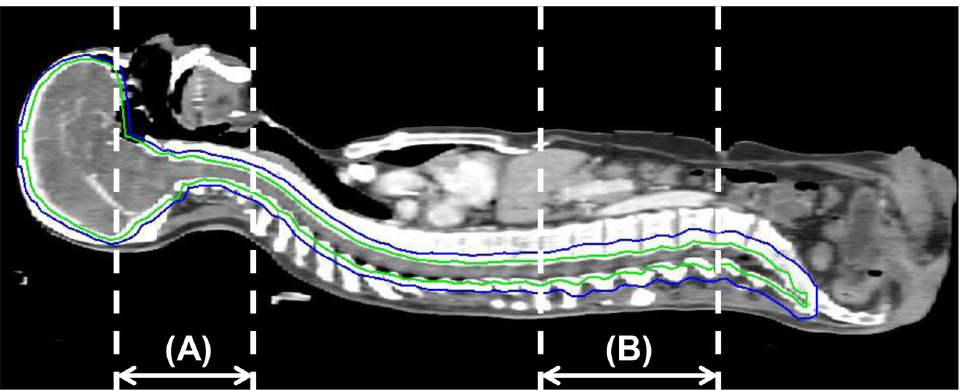
Figure 2. Target delineation for craniospinal irradiation (green line, clinical target volume [CTV]; blue line, planning target volume [PTV]) ( A ) Range of daily pre-treatment megavoltage computed tomography (MVCT). ( B ) Range of daily post-treatment